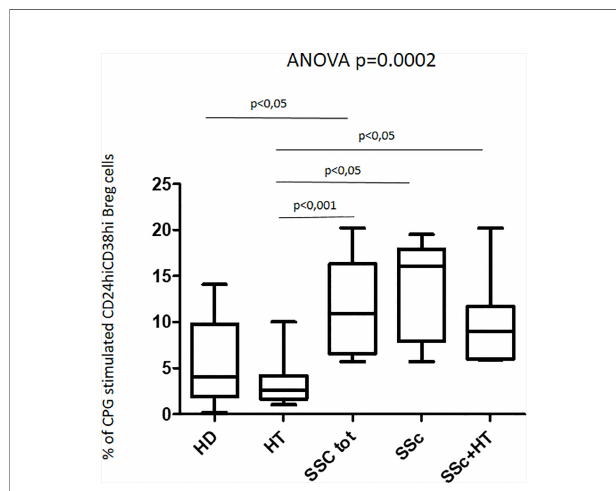
FIGURE 5 | Percentage of CpG-stimulated CD24hiCD38hi Breg cells in the whole patient sample with SSc, in those with isolated SSc, and in those with SSc+HT as compared with both patients with isolated HT and healthy donors (HD). Kruskal – Wallis followed by Dunn posttest was used for multiple comparisons.